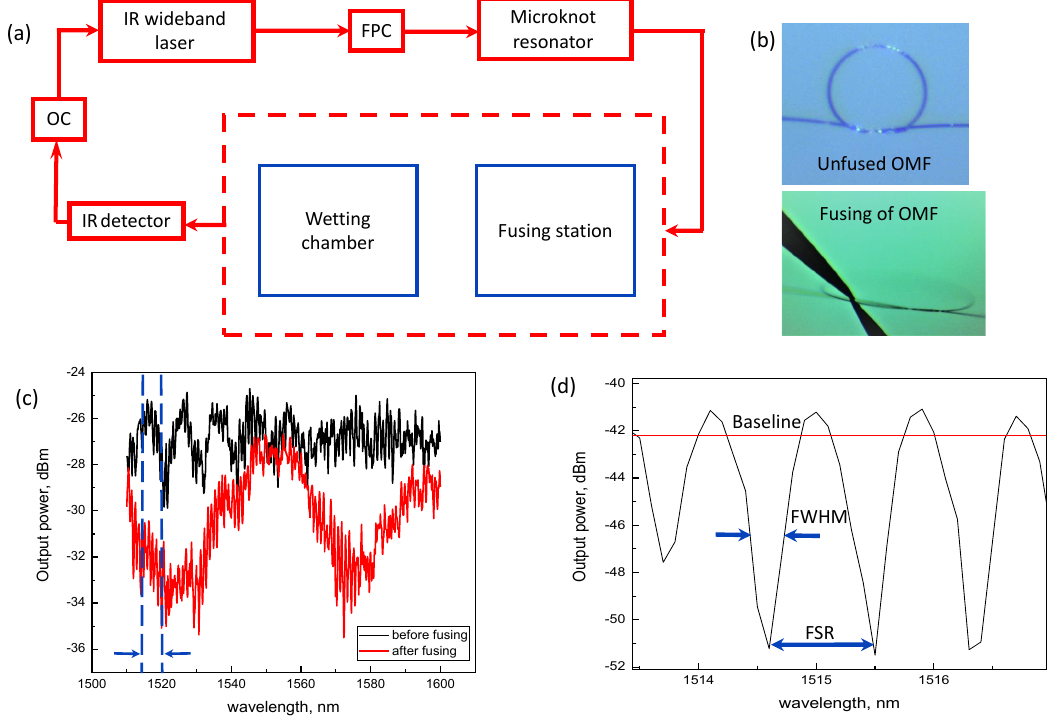
Figure 1. Basic experimental details. ( a ) Setup schematics; ( b ) Photographs of optical microknot fiber (OMF) before fusing (above) and during fusing (below); ( c ) Broad spectrum of OMF corresponding to the conditions in panel (b). Blue lines are the region of interest displayed in Figure 1d; ( d ) Magnified OMF spectrum within a narrow band. FPC: polarization controller; FSR : free spectral range; FWHM : full width at half maximum; IR: infrared; OC: operating